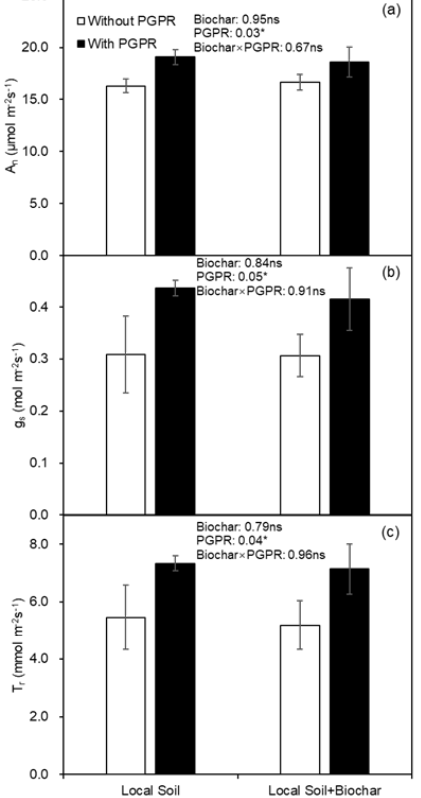
Figure 3. ( a ) Photosynthesis rate (A n ), ( b ) stomatal conductance (g s ) and ( c ) transpiration rate (T r ) of potato leaf as affected by biochar amendment and PGPR inoculation at first harvest. * indicates significance effect at p < 0.05 level, and ns indicates the effect was not statistically significant at p < 0.05 level.